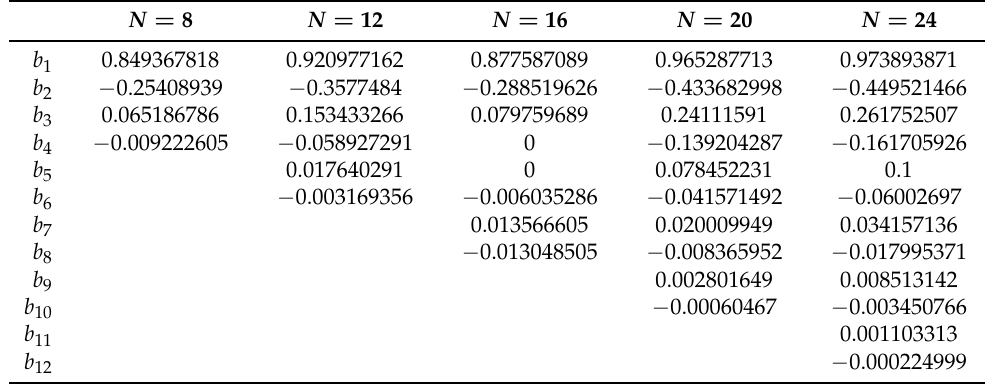
Table 2. The finite-difference coefficients for the first derivative optimized by PSO.